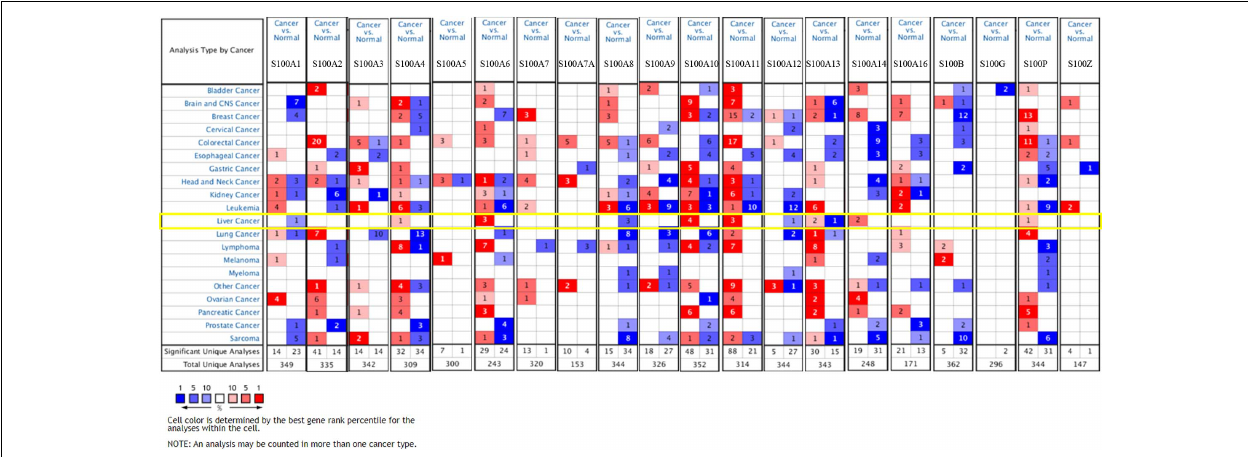
FIGURE 1 | The transcription levels of S100 family members (S100s) in different types of cancers (Oncomine database). Cells in red color represents the overexpression of interested gene, while lowexpression shows in blue. The numbers in these cells represents the numbers of datasets which satisfies the threshold: p -value: 0.001, fold change: 1.5. The levels of S100A4/S100A6/S100A10/S100A11/S100A13/S100A14/S100P were higher in tumor than in normal liver samples, while S100A8 were downregulated.